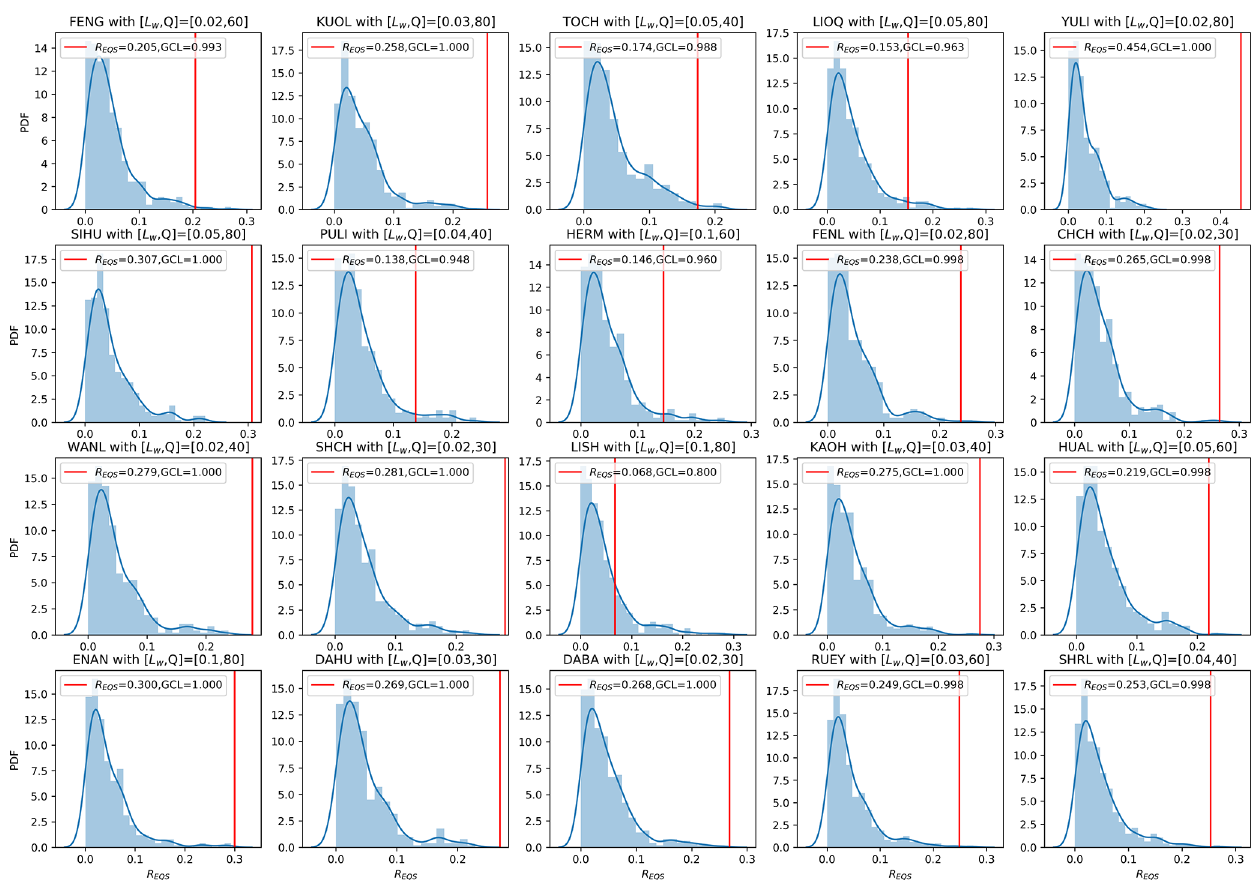
Figure 12. Histograms (blue) of 400 simulated R EQS values compared against the empirical R EQS (vertical red line) for 20 stations and R D _min = 0 . 95, with the GCL values in the legends. The hyperparameters of L w and Q optimized for each station are shown in each subplot’s